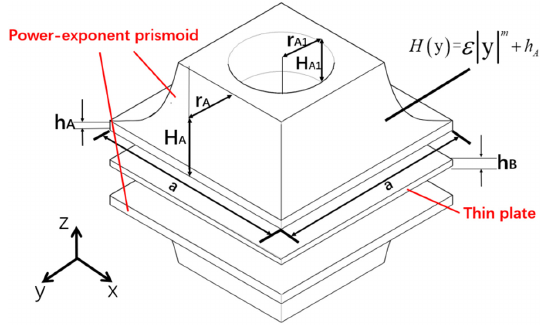
Figure 2. Protocell of the photonic crystal.